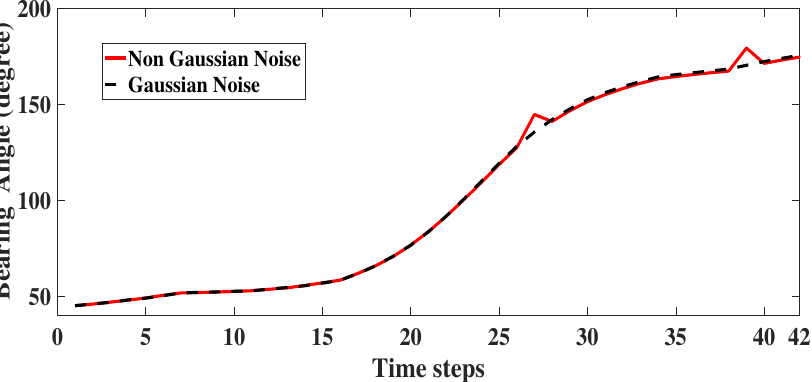
Figure 7. 3D: Bearing angle measurement with glint plus shot noise.